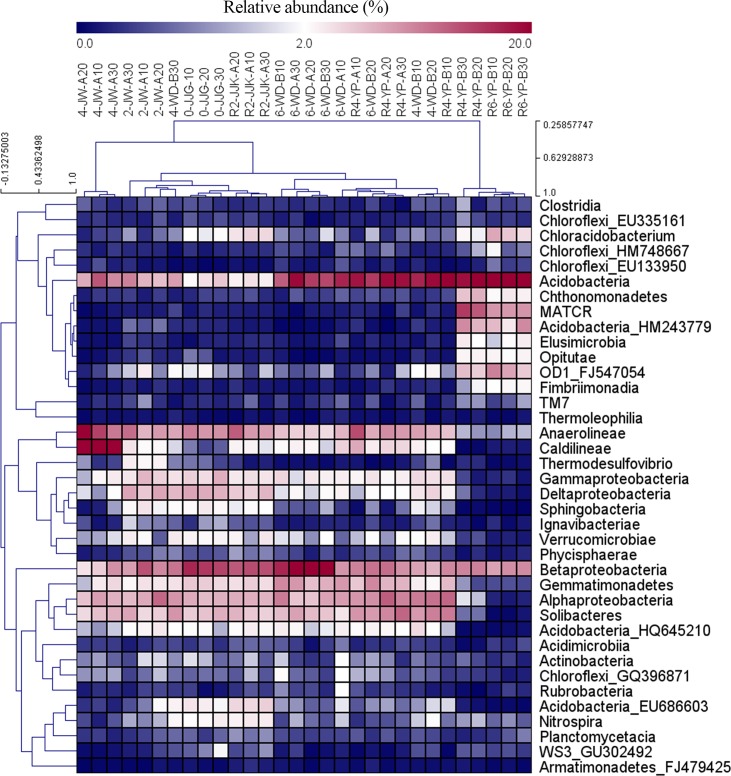
Heat map analysis showing the distributions of the core bacterial classes.